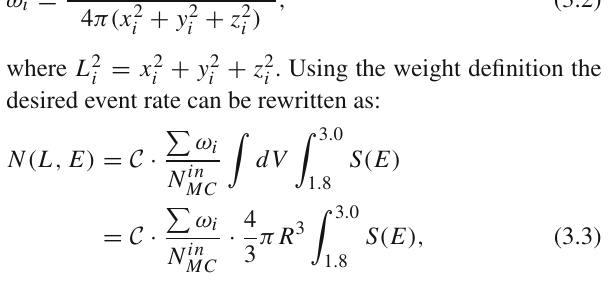
position Iposition II 2R = 16.4